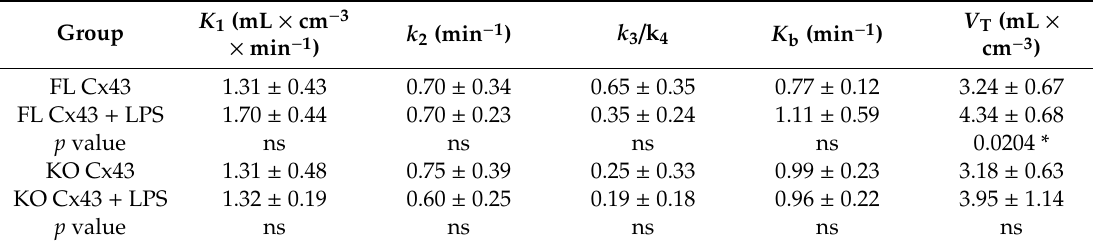
Table 1. Pharmacokinetics parameters for [ 18 F]FEPPA distribution in the whole brain of FL Cx43 and KO Cx43 ± LPS groups (n = 5–7). Mean ± SD.